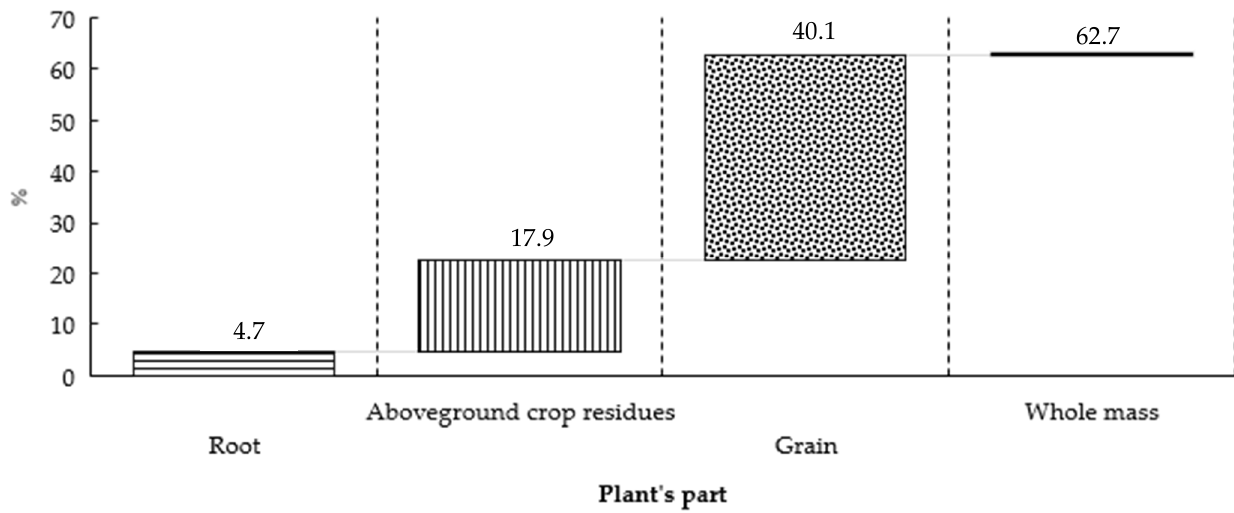
Figure 2. Utilization coefficient of nitrogen introduced into the soil with pea residues by winter triticale (means for peas cultivars), %.